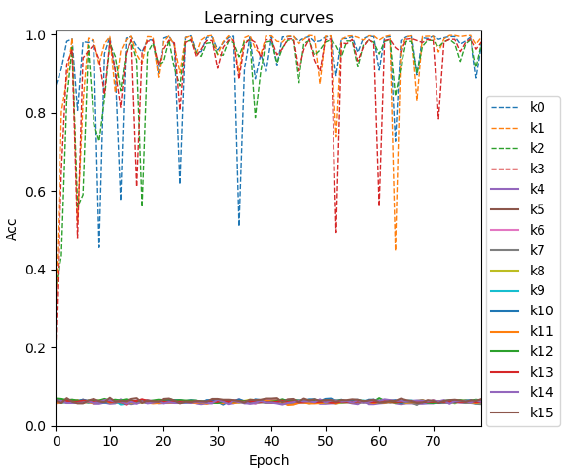
Figure 3. Result of directly using the initial key as the attack point to attack SPECK.